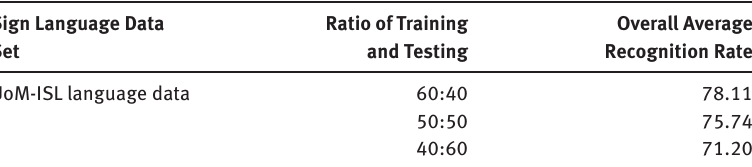
Table 6: Performance of the Proposed Method in Terms of F-measure for Different Percentages of Training and Testing for User- Independent Sign